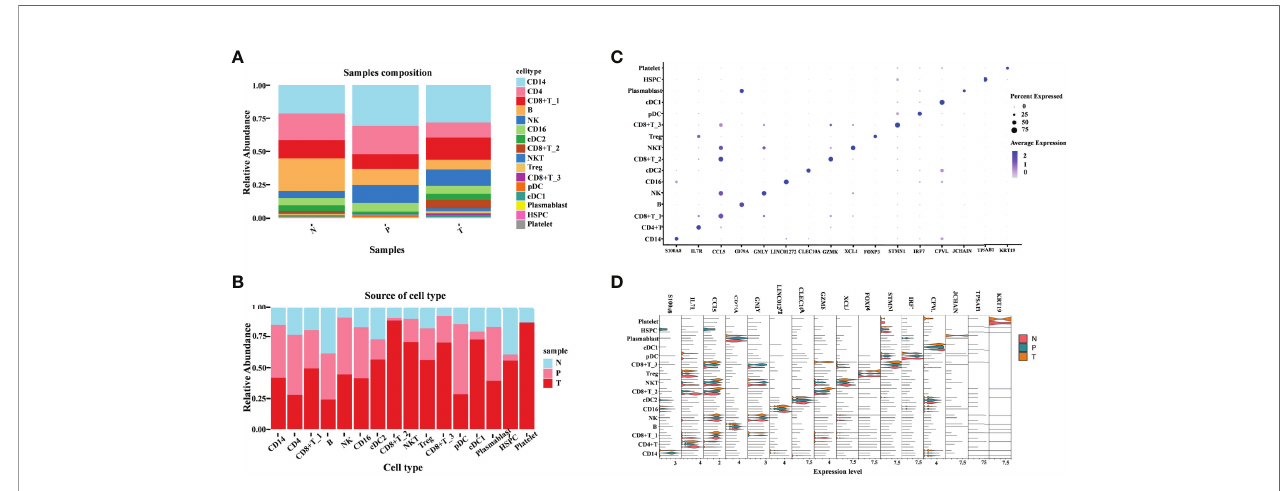
FIGURE 2 | Illustration of the heterogeneity of ccRCC tumor immune environment in different tissue types. (A) Cell-type abundance in each tissue type. Each bar corresponds to one tissue type, colored according to the cell types. (B) Sample distribution in each cluster. Each bar corresponds to one cell-type cluster, colored according to the samples. (C) Dot plot of canonical cell-type markers of 16 major cell types. The circle size indicates the percentage of genes expressed in a cell. The darker the color indicates a higher average expression level. (D) Violin plot of canonical cell-type markers of 16 major cell types in different tissue